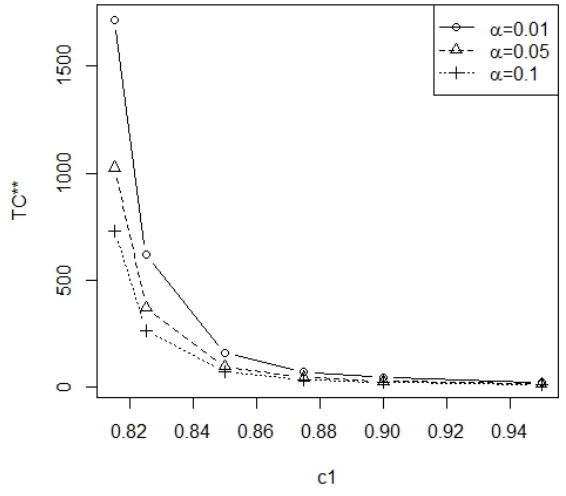
Figure 7. The minimum total cost curve or α = 0.01, 0.05, 0.1.